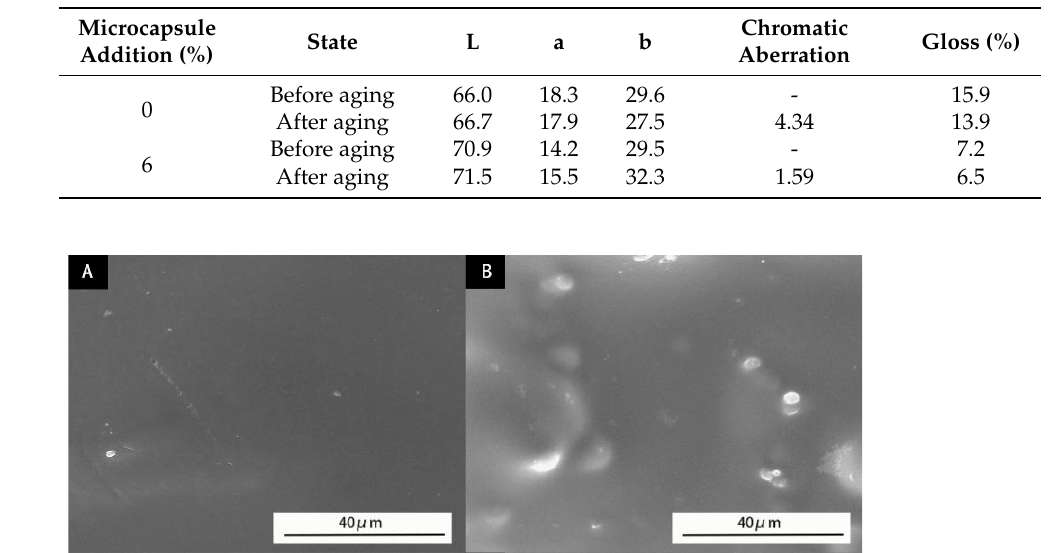
Table 12. Changes of color difference and glossiness of water-based primer with different contents of microcapsules after the aging test.